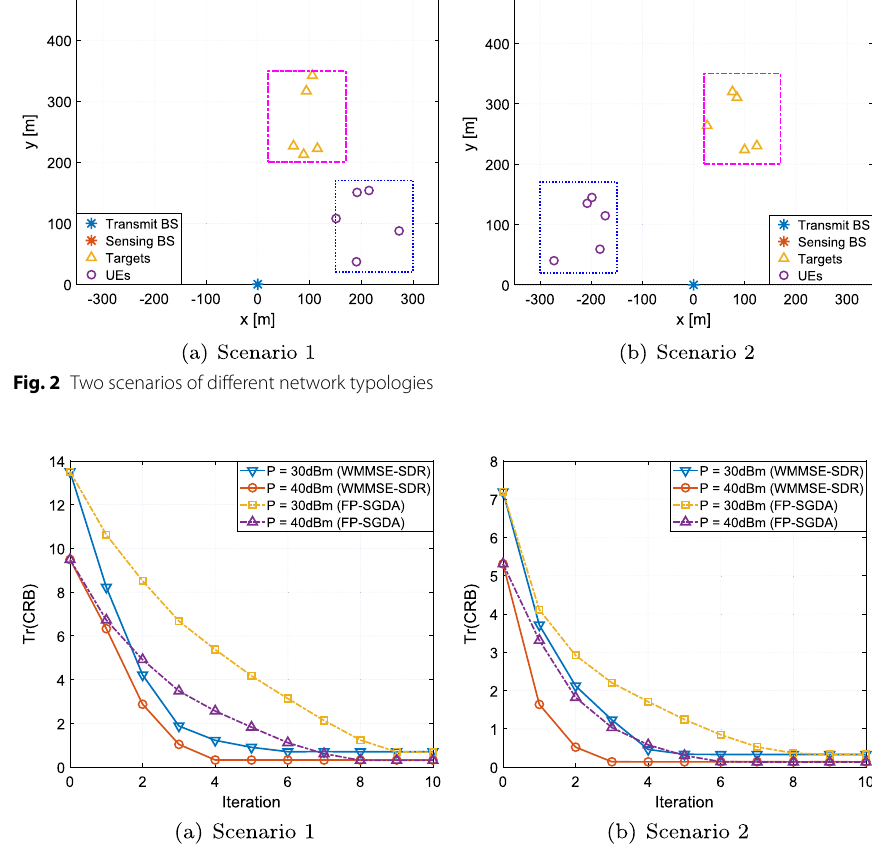
Fig. 3 Comparison of convergence of WMMSE–SDR and